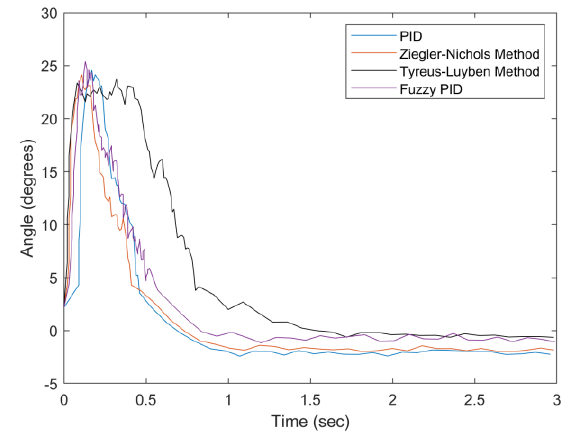
Figure 32. Convergence of angle with weight = 150 g.